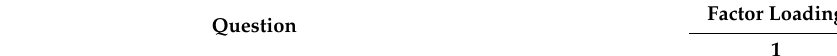
Table 4. Attitude factors